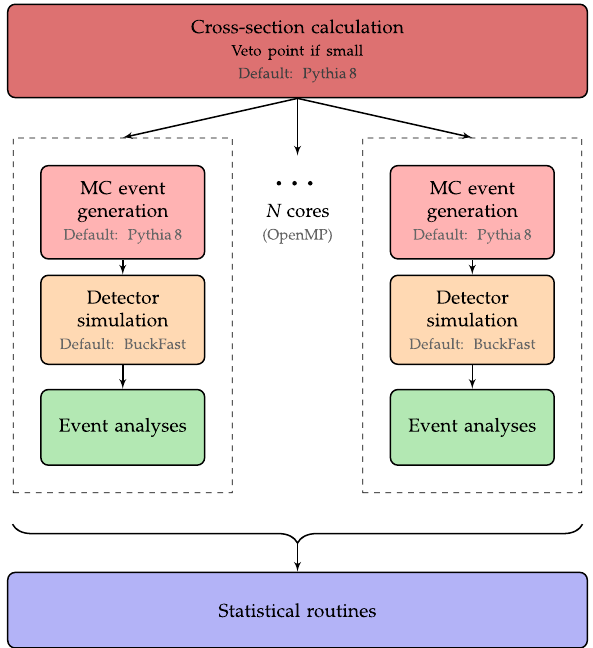
Fig. 1 Schematicdiagramofthe ColliderBit processingchainforLHC